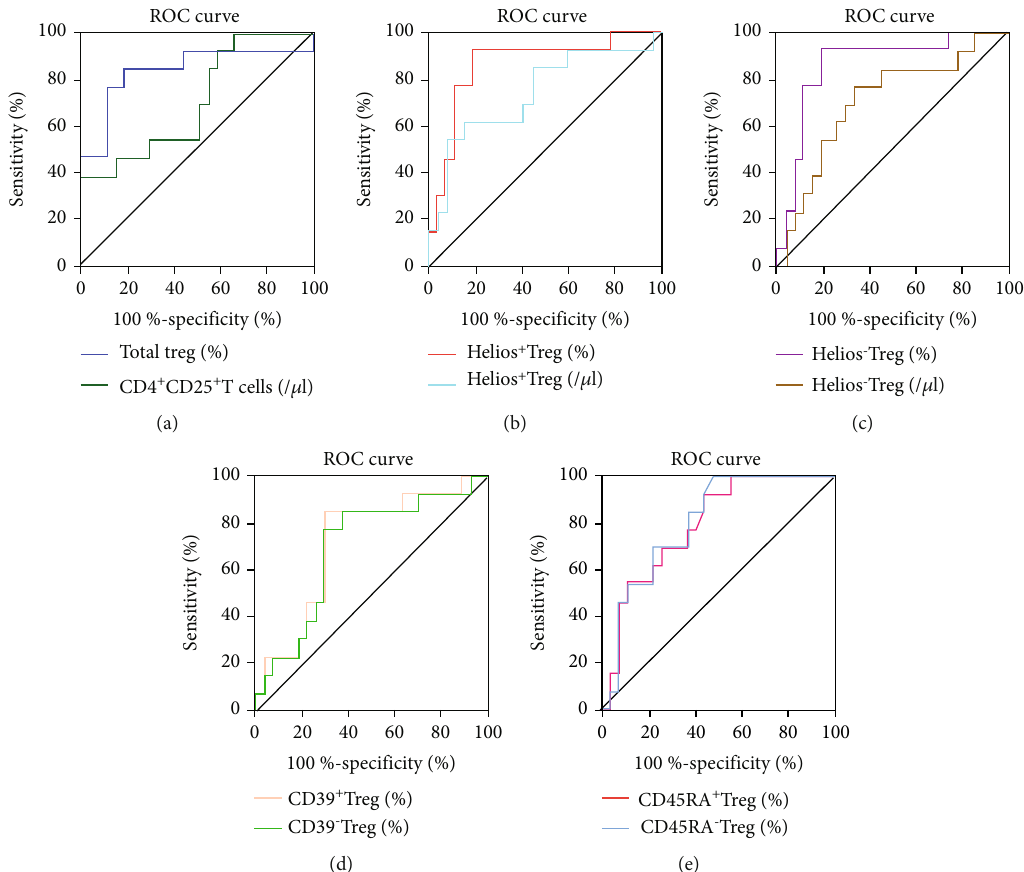
Figure 5: ROC curve of Treg subpopulations in MP and SP patients. (a) ROC curve of CD4 + CD25 + T cells (Ab No.) and total Treg (%). (b) ROC curve of Helios + Treg (% and Ab No.). (c) ROC curve of Helios - Treg (% and Ab No.). (d) ROC curve of CD39 + Treg (%) and CD39 - Treg (%). (e) ROC curve of CD45RA + Treg (%) and CD45RA - Treg (%). Table 5: Areas under the curve (AUC) and cut-o ff values of Treg subsets.